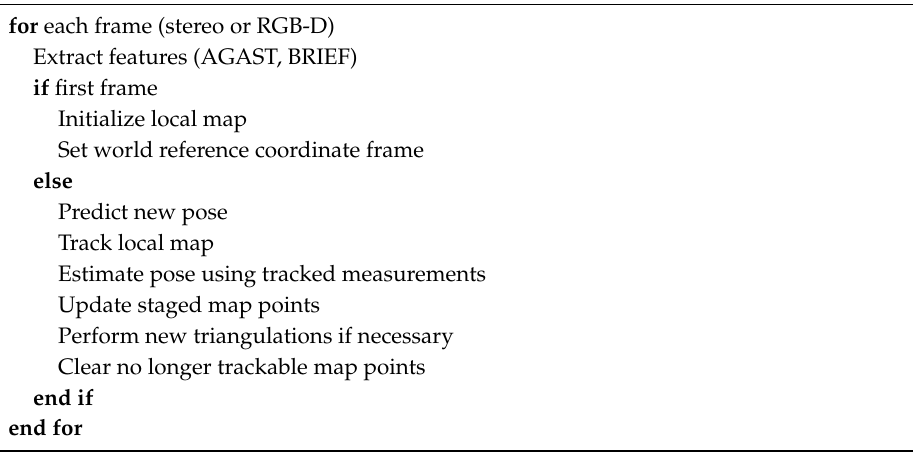
Algorithm 1. Visual Odometry Algorithm